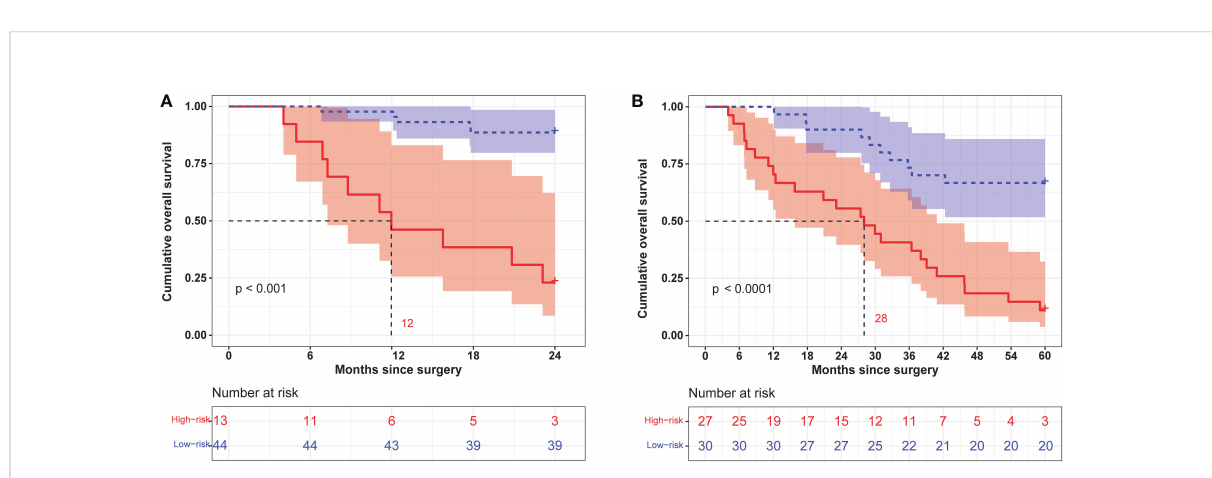
FIGURE 7 Kaplan – Meier curves of 2-year (A) and 5-year (B) overall survival in different risk groups classi fi ed according to the nomogram